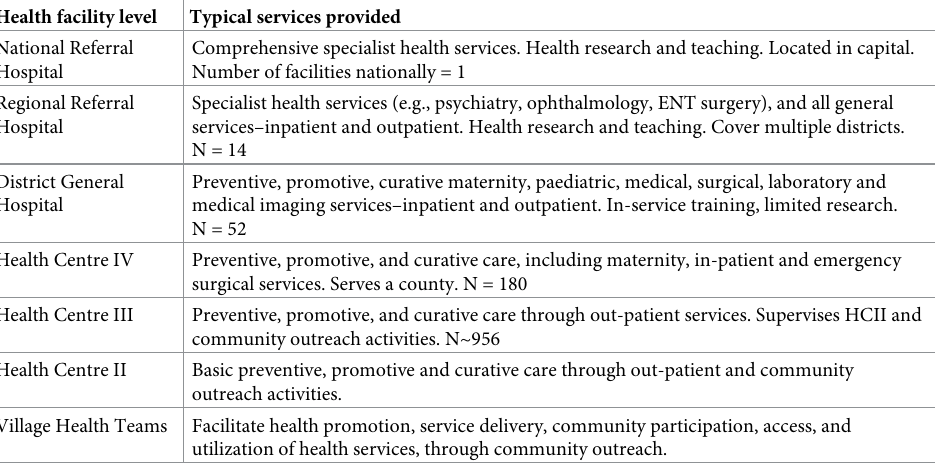
Table 1. Overview of the levels of health facilities in Uganda, and typical health services provided